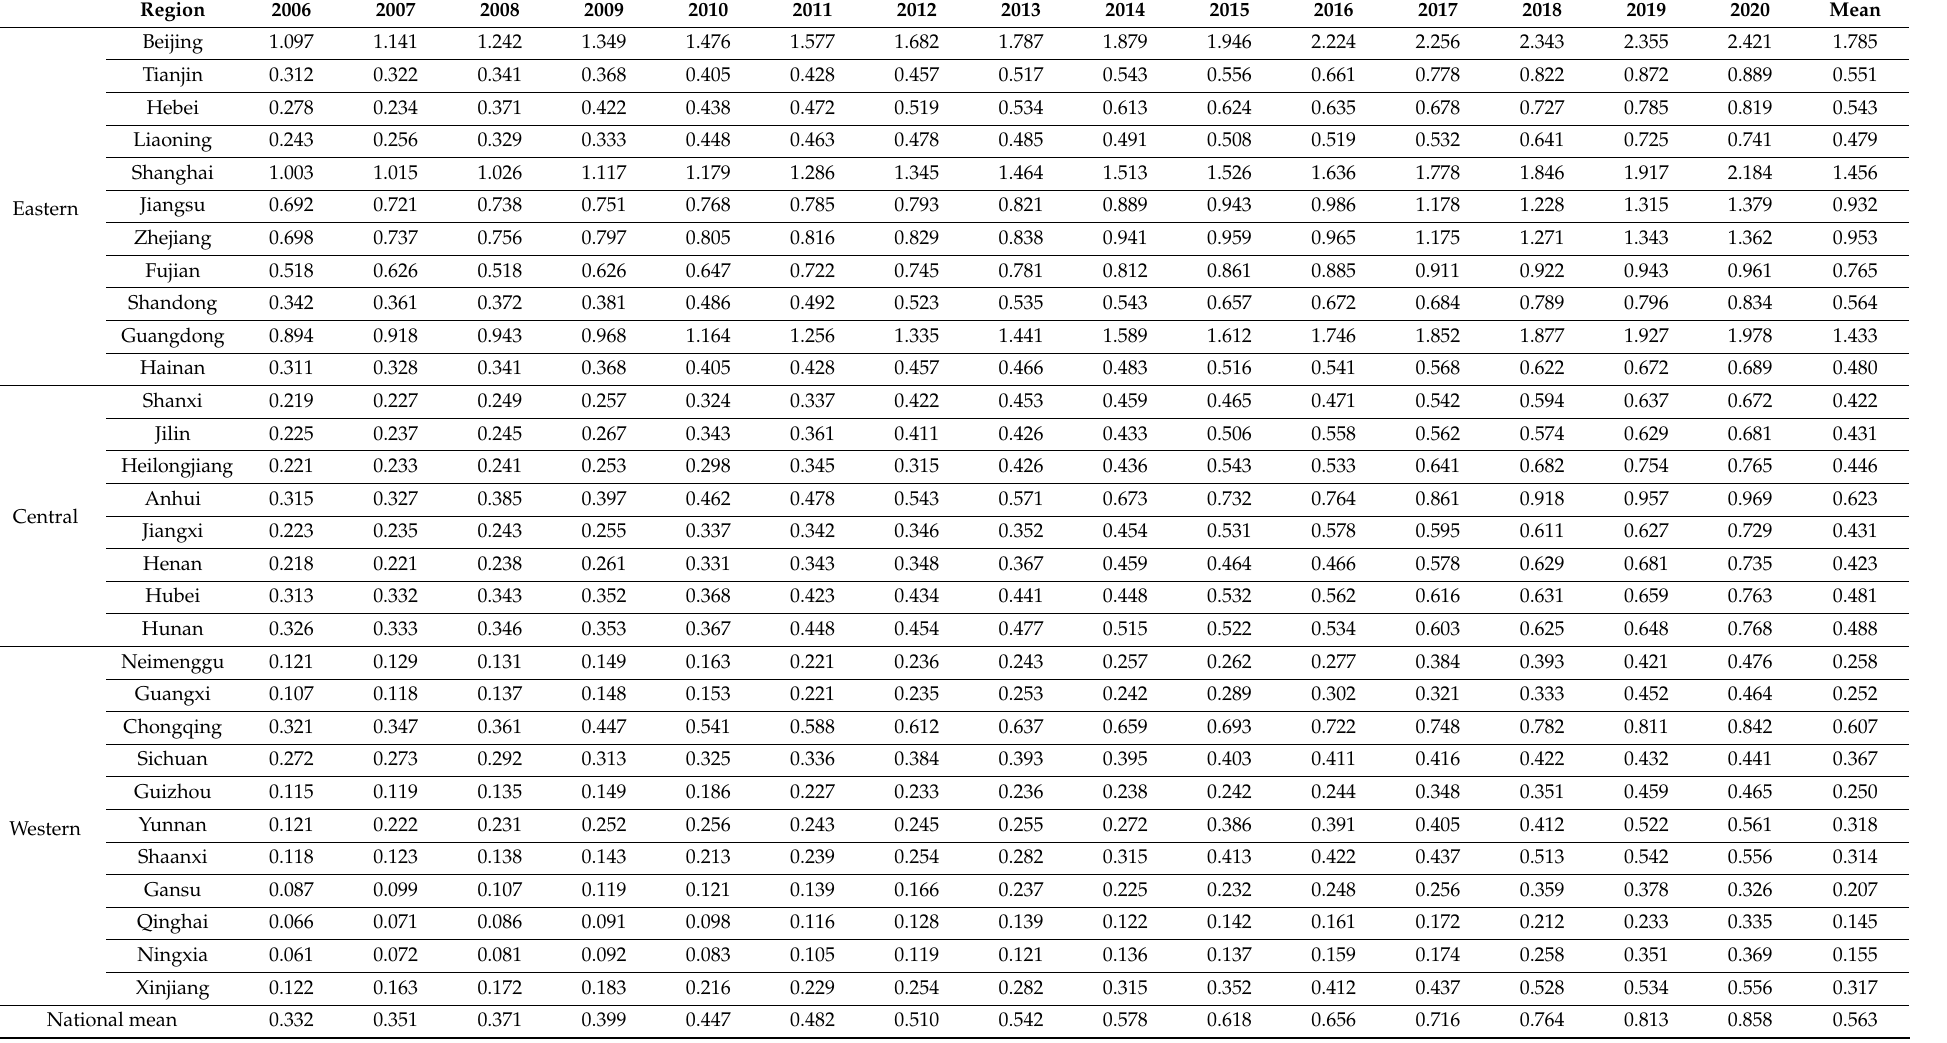
Table 2. EE measurement